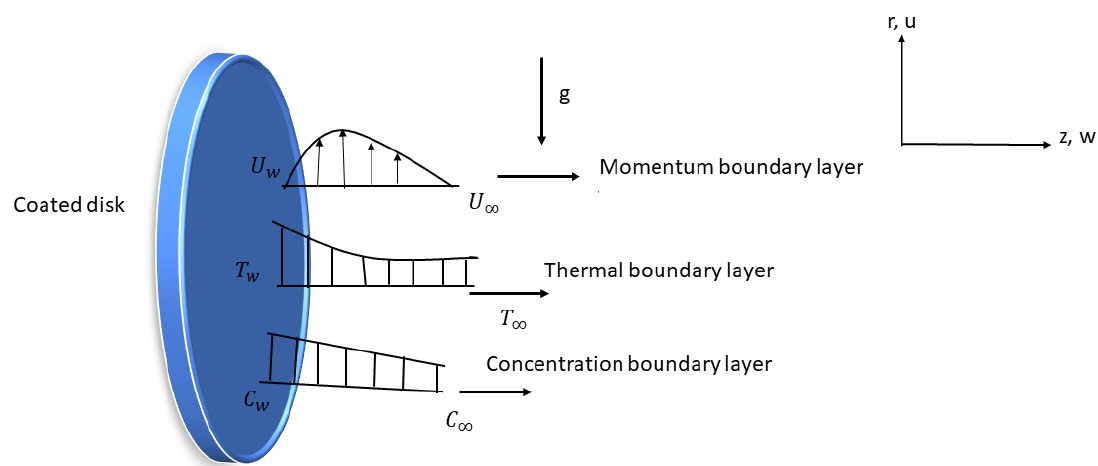
Figure 1. Geometry of the Carreau fluid flow over a coated surface.